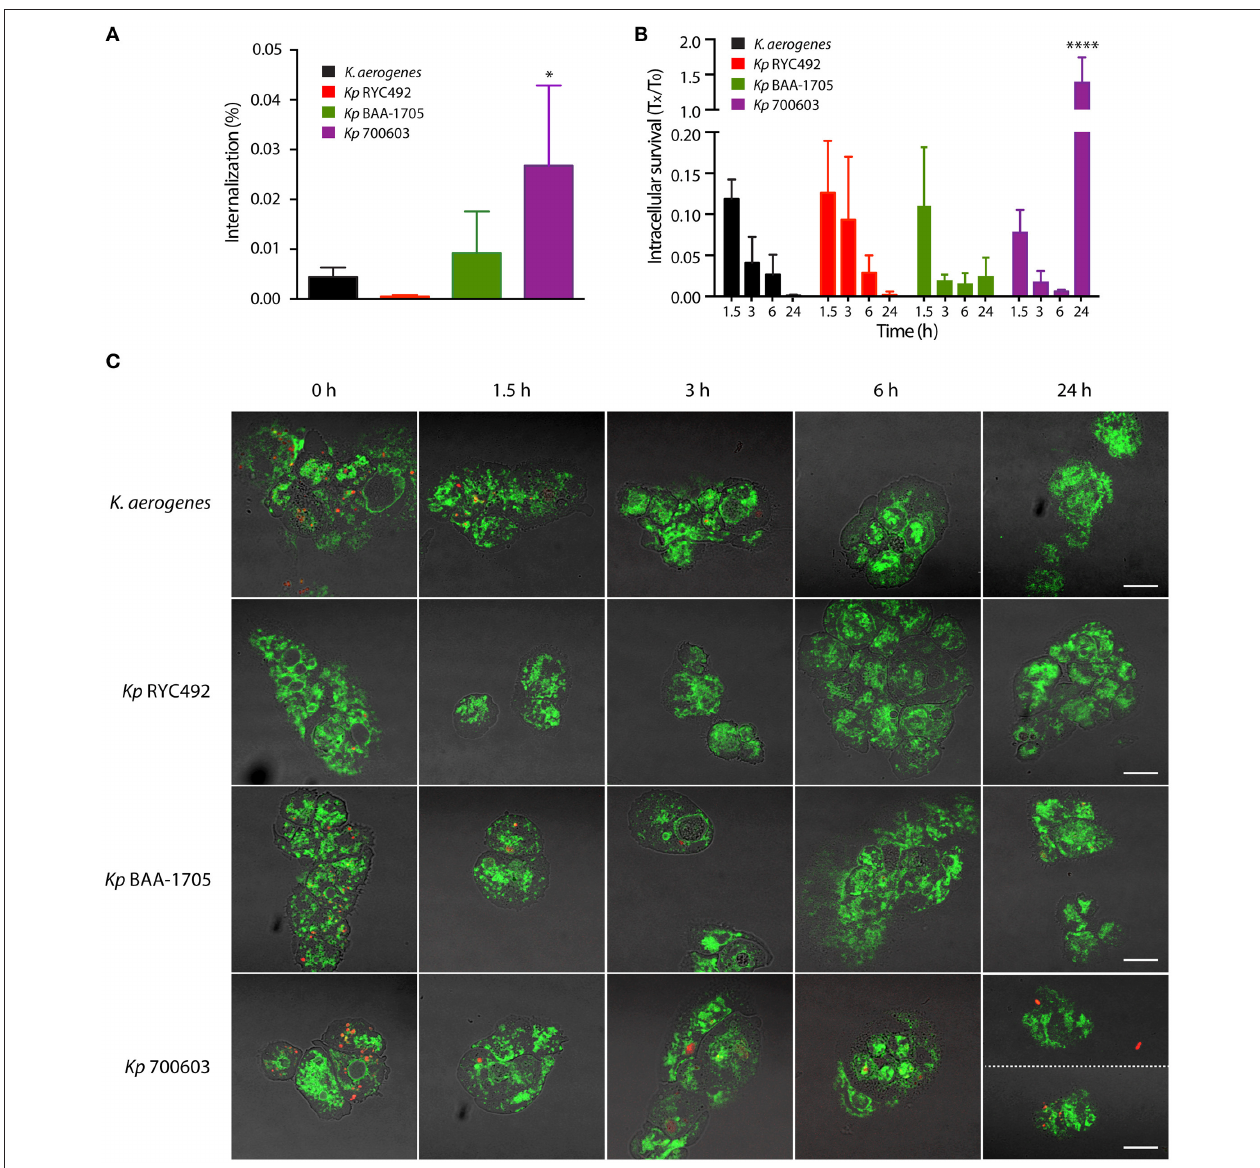
FIGURE 2 | Bacterial phagocytosis assays revealed differences in invasiveness and intracellular survival among different K. pneumoniae strains. (A) Percentage of bacteria that were internalized after co-incubation of amoebae- Klebsiella for 1h. (B) Total intracellular bacteria were titrated at the indicated times (T x ), and the results were expressed as the fraction respect the survival at time zero (T 0 ). In both (A,B) , the symbols represent the mean of three independent experiments and the standard deviation. * p < 0.05, **** p < 0.0001. (C) Live-cell imaging of D. discoideum cells (green) interacting with Klebsiella (red), representative of the experiments showed in (A,B) . Bright field and fluorescence images were blended in order to better appreciate the boundaries of the amoeba cells. At time 24h, two pictures of amoebae infected with Kp 700603 are shown in order to illustrate that both extracellular (upper picture) and intracellular bacteria (lower picture) could be observed. Scale bar, 10 µ